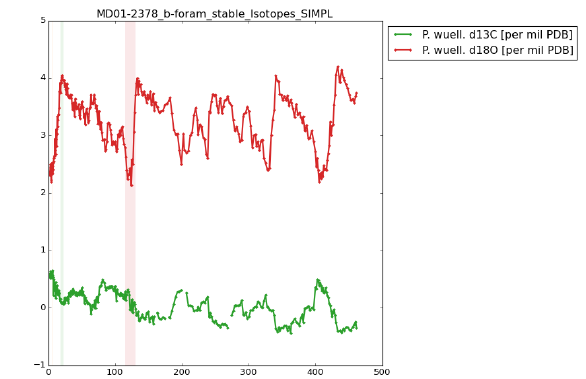
Figure 1. Web portal screen captures illustrating the search crite- ria (a) , the resulting maps (b) , and the time-series plot (c) .